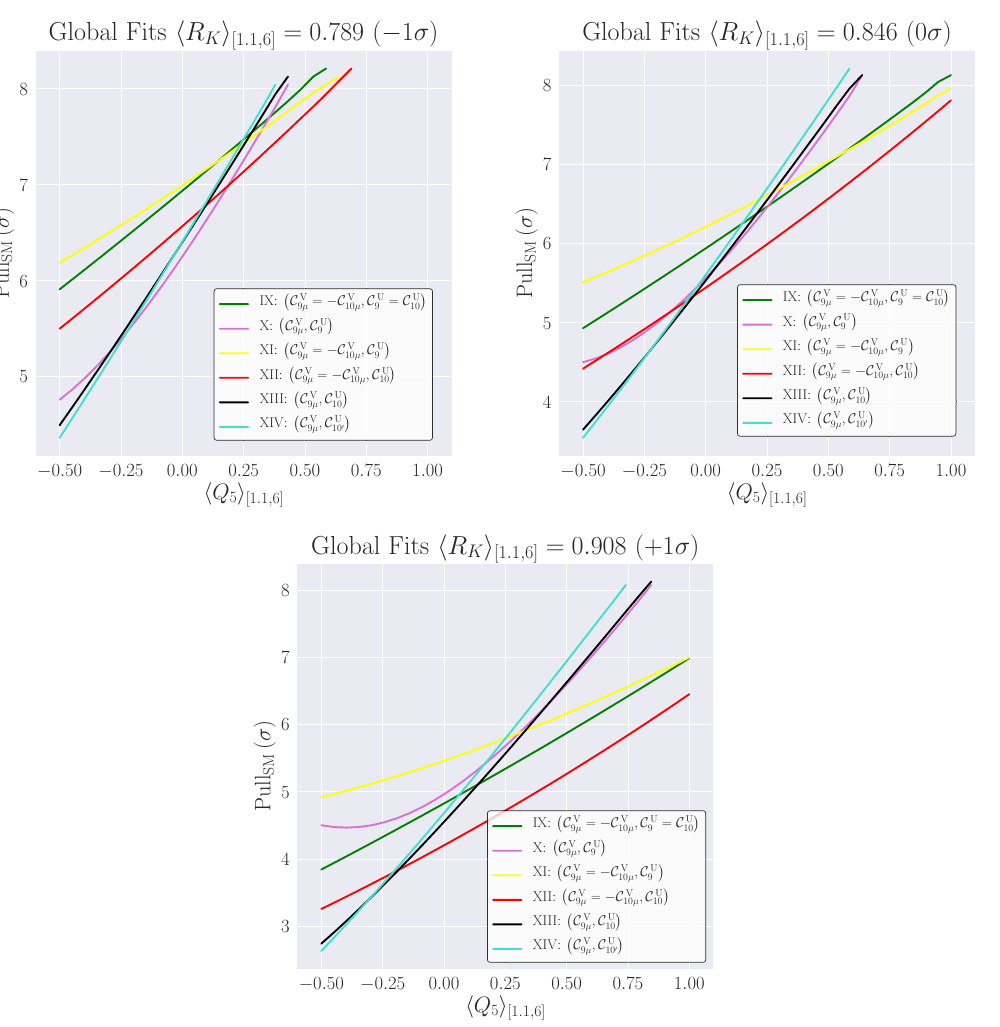
Figure 6. Global fit: impact of for different values of